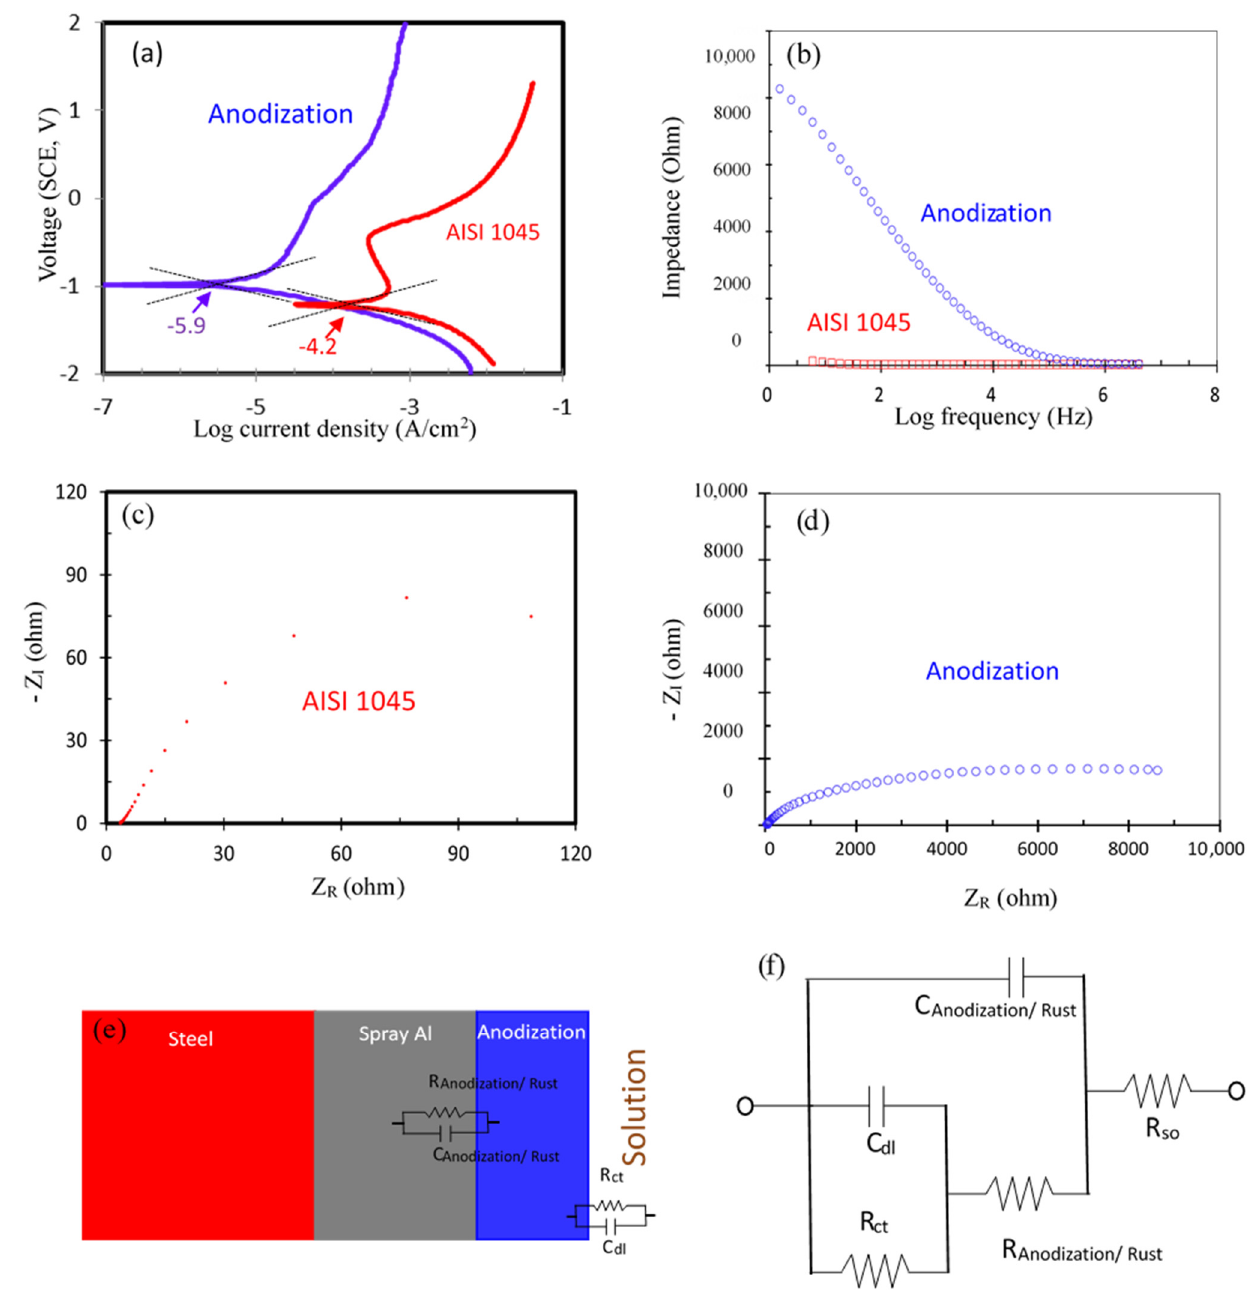
Figure 14. Electrochemical test curves of AISI 1045 and anodization: ( a ) Tafel curve, ( b ) Bode plot, ( c ) Nyquist plot of AISI 1045, and ( d ) Nyquist plot of hard anodized film on AISI 1045, ( e ) structure of films on AISI 1045, ( f ) Equivalent circuit.